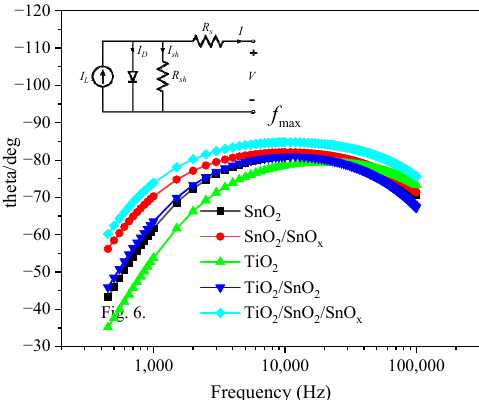
Figure 5. Nyquist plots of PSCs fabricated with the different conditions of ETL at: ( a ) light condition and ( b ) dark condition. Fig. 6.